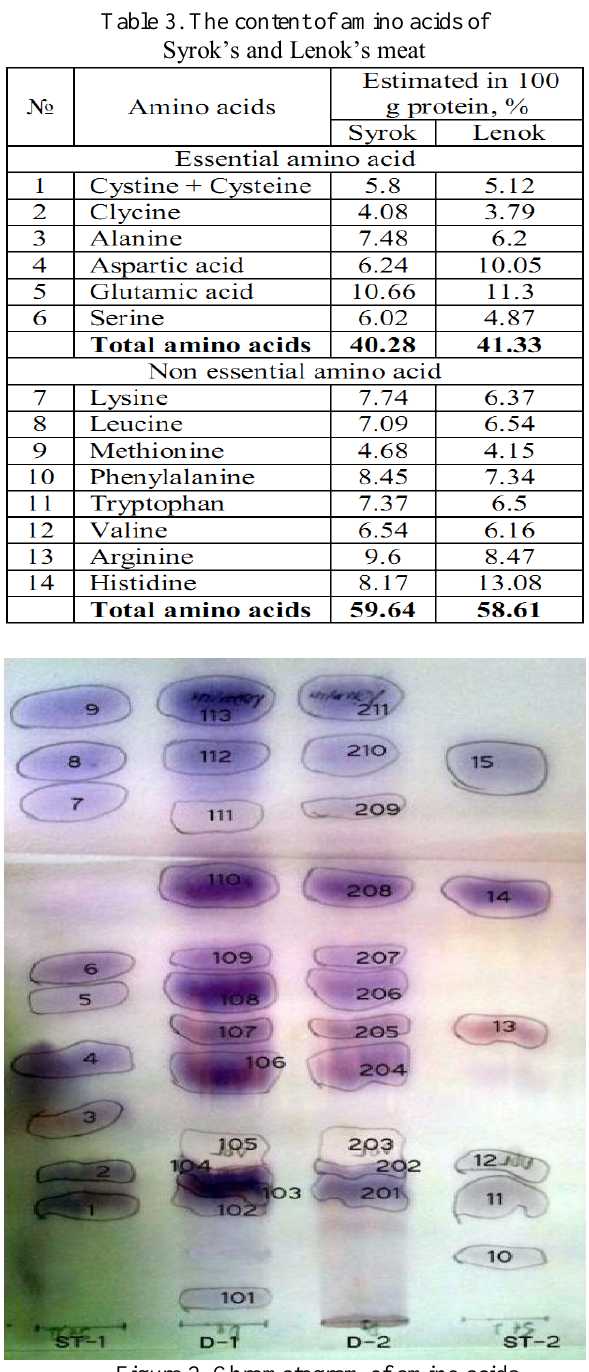
Figure 2. Chromatogram of amino acids